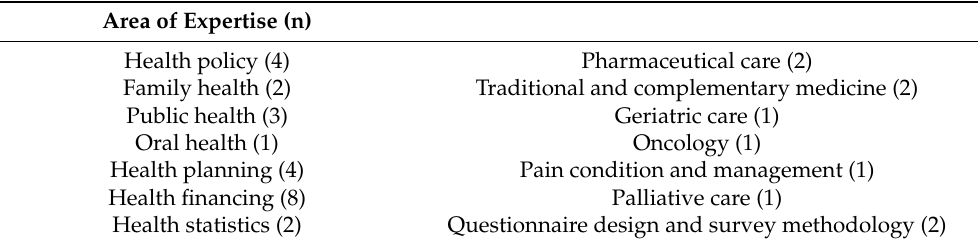
Table 1. Stakeholders involved in the questionnaire redesign process, based on the area of expertise ( N =